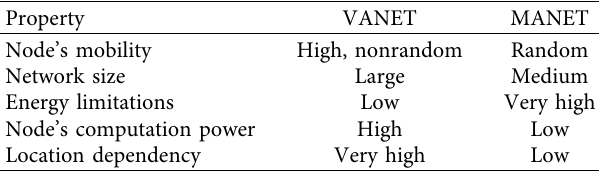
Table 1: Summary of VANET and MANET